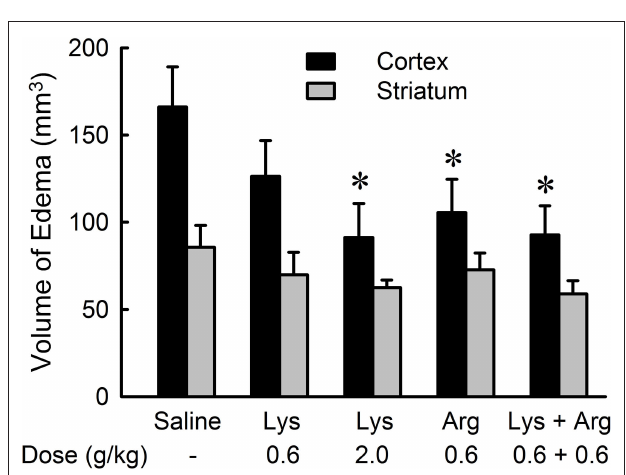
FIgure 1 | examples of five consecutive coronal brain images of MCAO rats administrated with (A) saline or (B) lysine as measured by T Brain areas with hyperintensity (i.e., increase in water content) was observed in the